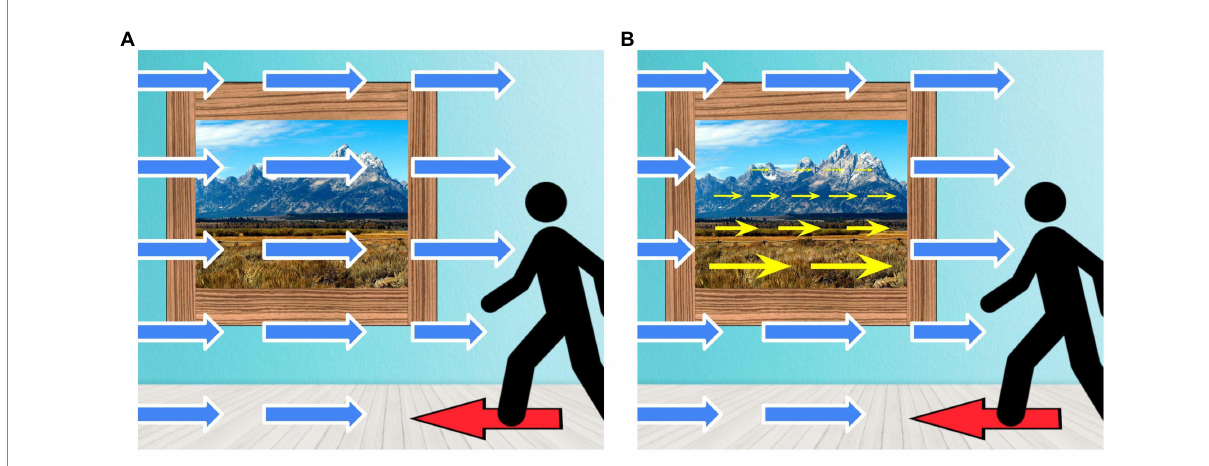
FIGURE 6 Locomotion generates optic flow, a visual pattern that is directly informative to the agent of her direction of movement. The two images provided here illustrate the optic flow (arrows pointing to the right) that gets generated as a person walks to the left side of the room (red arrow on floor). The specific character of the optic flow can be informative of whether the mountainous landscape is a picture hanging on the wall or an actual scene viewed through a window: if, as you move forward, the optic flow generated is the same everywhere, then what you see is a picture (A) , whereas the rate and quality of visual change for the real scene is specific to a space with depth (B) . In the computational conception of cognition, locomotion is the output of cognition (e.g., the execution of a motor plan) and what you perceive becomes the input for further cognitive processing. In contrast, in the ecological view, insofar as it generates optic flow, locomotion is itself cognitive: it is a process through which an agent gains epistemic access to (i.e., comes to know) aspects of the environment and of the agent’s relation to